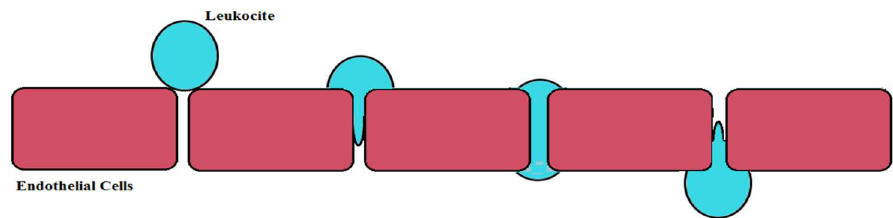
Figure 3. Loss of the blood-brain barrier (BBB) integrity facilitates pro-inflammatory and leukocytes infiltration.